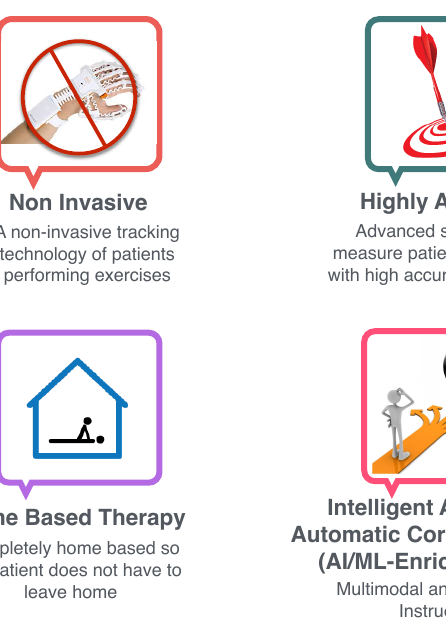
Figure 1. Required features for building adaptive serious